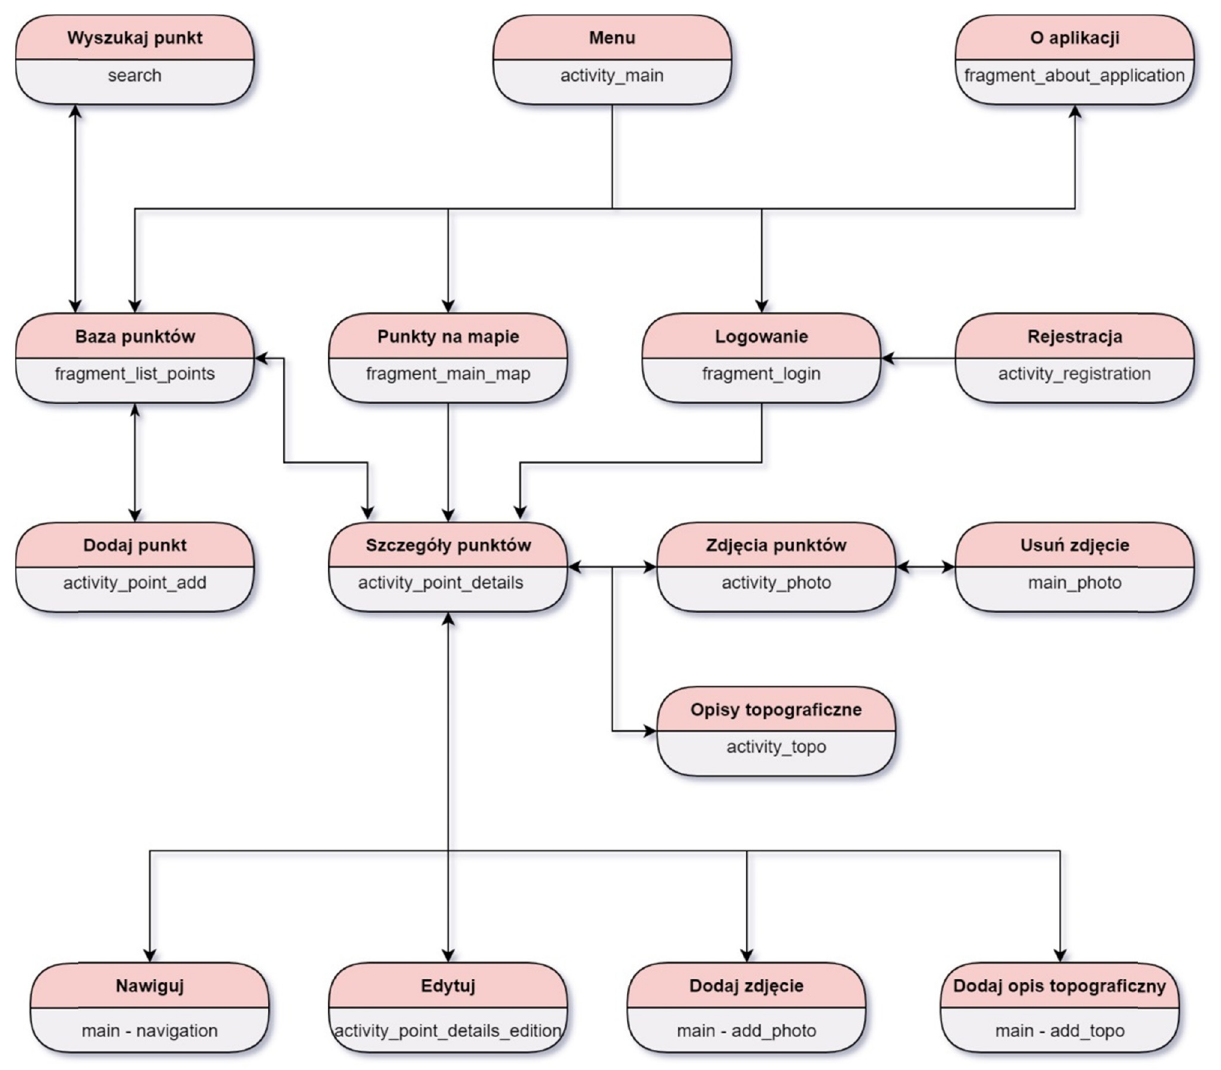
Figure 9: Schematic of the transitions between the di ff erent views in the